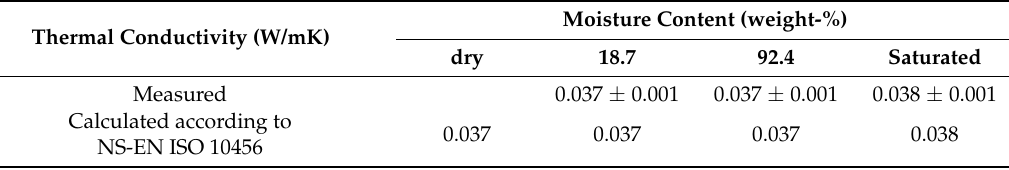
Table 3. Measured and calculated (according to NS-EN ISO 10456) thermal conductivity of wood-fibre insulation as function of moisture